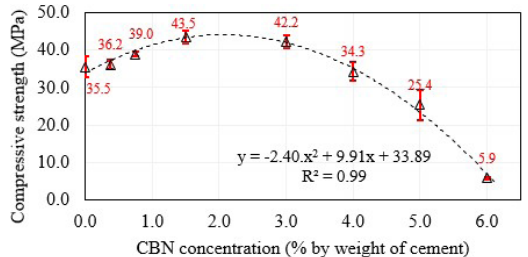
Figure 2. 28-days compressive strength of mortars with different CBN contents.